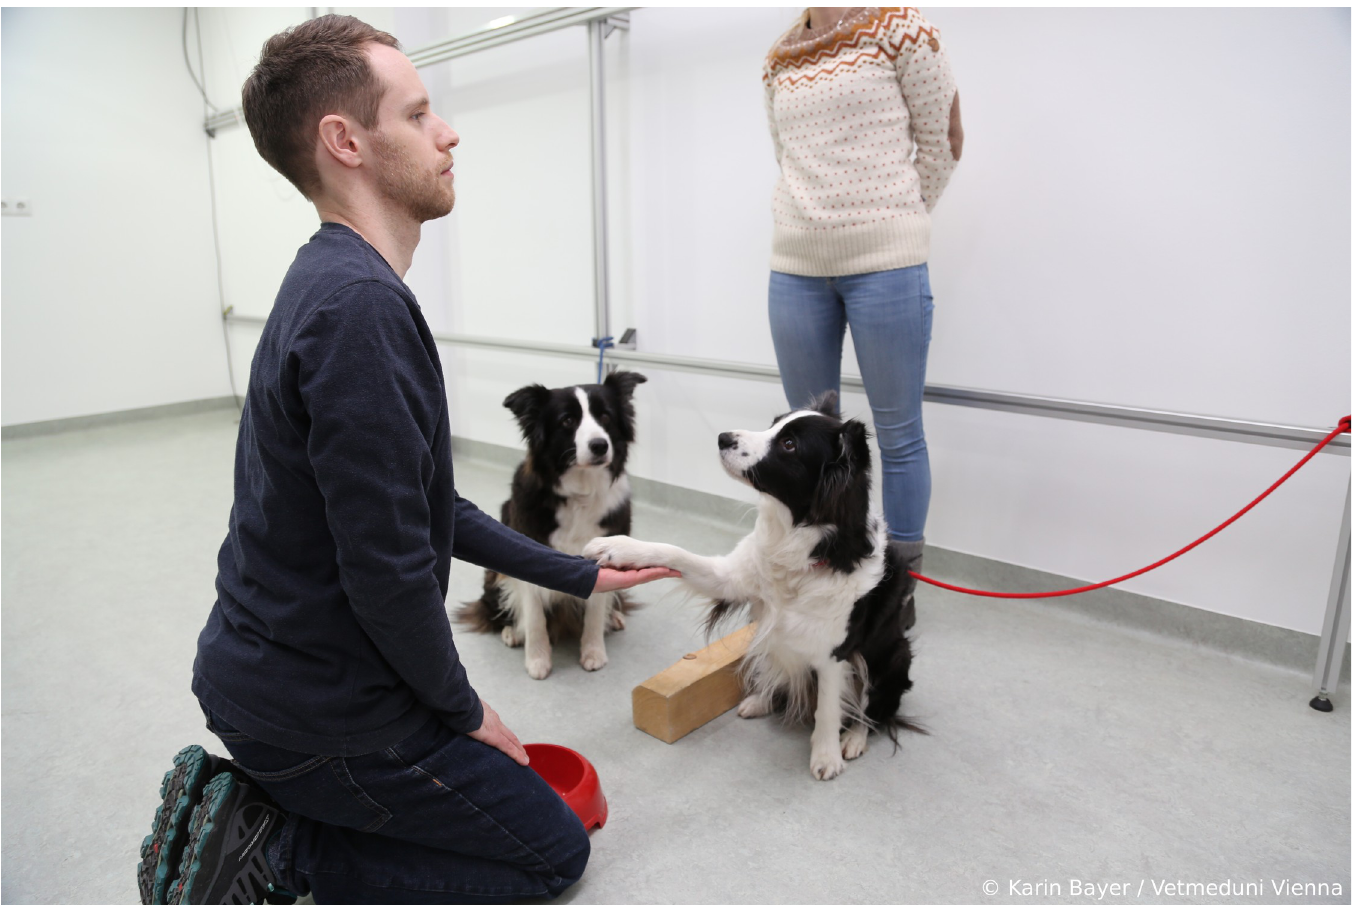
Fig 1. Paw task. The experimenter kneels in front of the two dogs, with a bowl of food, and asks each dog for its paw, before rewarding it, or not, depending on the condition.